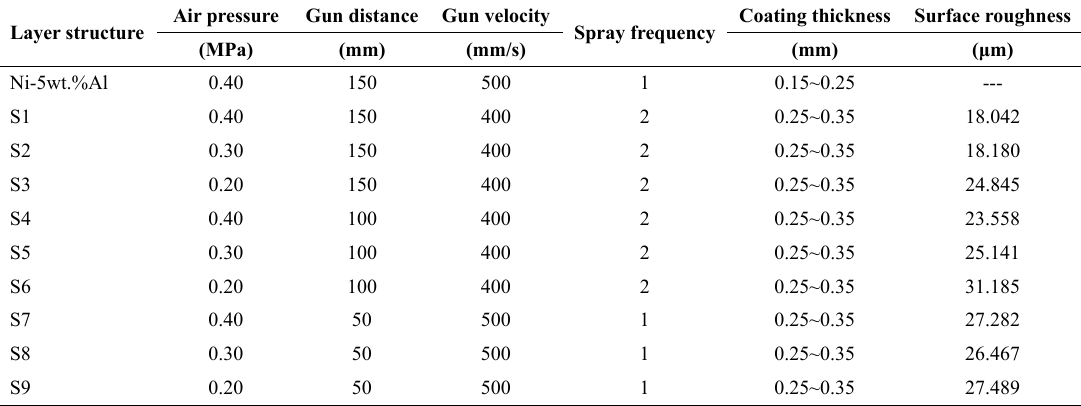
Figure 14 is the surface morphology and three-dimensional morphology of the coating S2. Figure 14a is the laser confocal microscope to observe the surface morphology, Figure 14b is the SEM morphology, Figure 14c and Figure 14d are the microscope to observe the roughness and three-dimensional morphology of the coating respectively. There are no cracks on the coating surface, and it is uneven and roughness is larger 21, 22 .